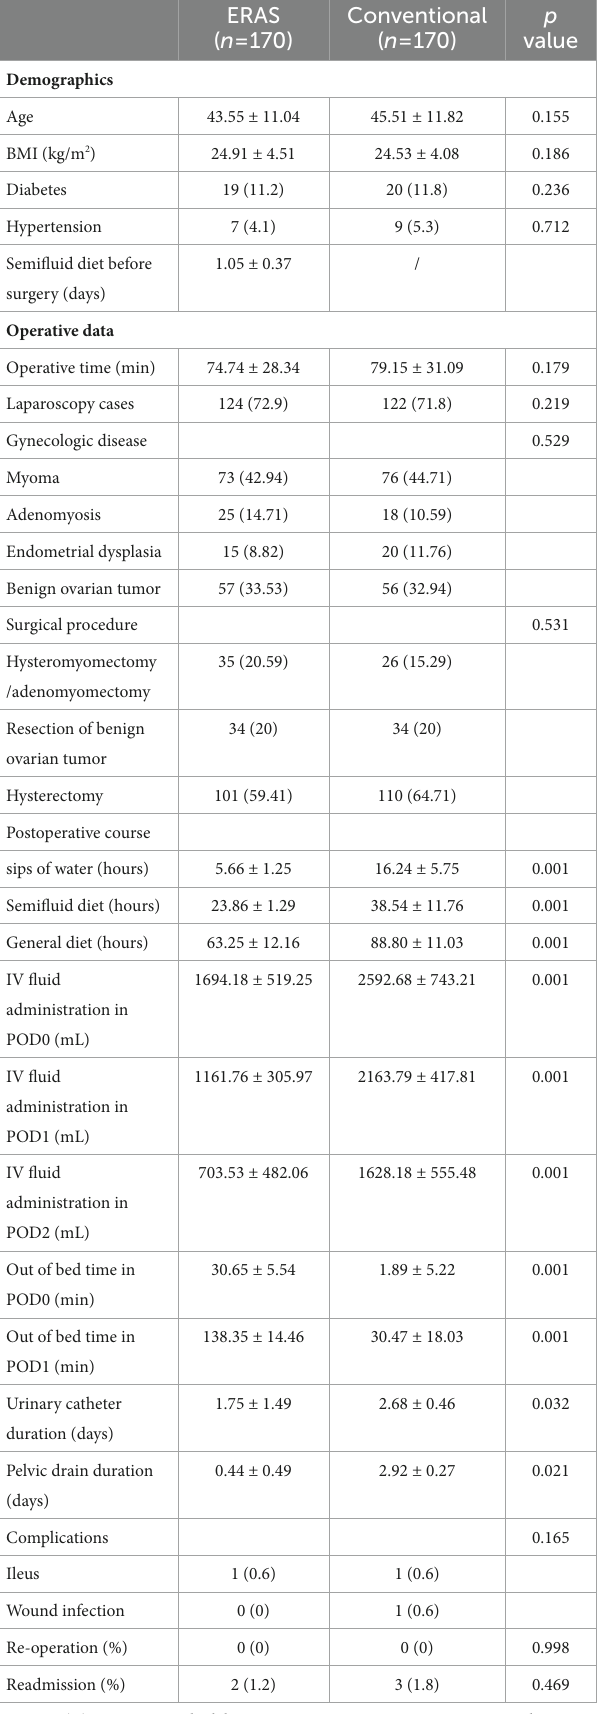
TABLE 2 Patient baseline data and perioperative